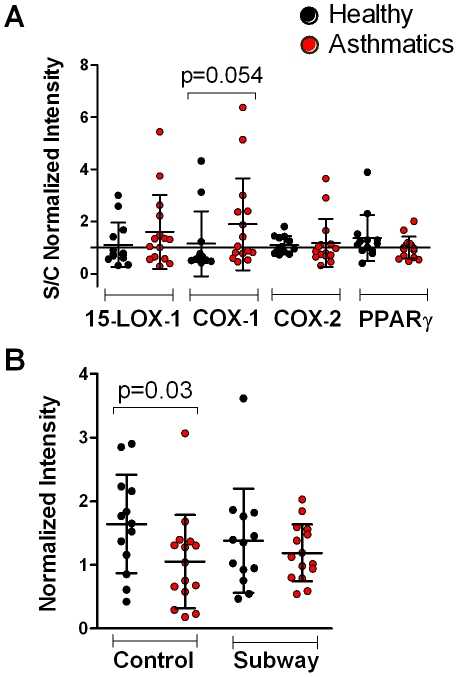
Semi-quantitative analysis of immunostained cytospun BAL-cells.(A) Baseline normalized expression levels (Subway/Control, S/C) for immunostaining of BAL-cells revealed an intensified response in asthmatics compared to healthy individuals for COX-1 (p = 0.054). Values >1 indicate an increase in concentration following subway air exposure and values <1 indicate a decrease. (B) Analysis of the subway air and control exposures as separate groups gave significantly lower COX-1 levels in asthmatics compared to healthy individuals at baseline levels (p = 0.03).